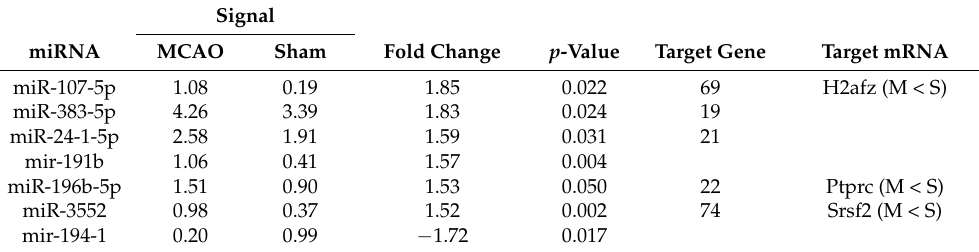
Table 4. Significantly regulated miRNAs in blood.